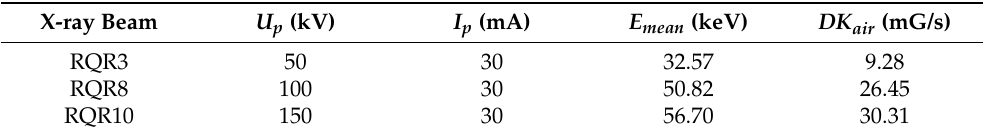
Table 1. The X-ray beam type, tube potential ( U p ), tube current ( I p ), mean energy ( E mean ), and air kerma rate ( DK air